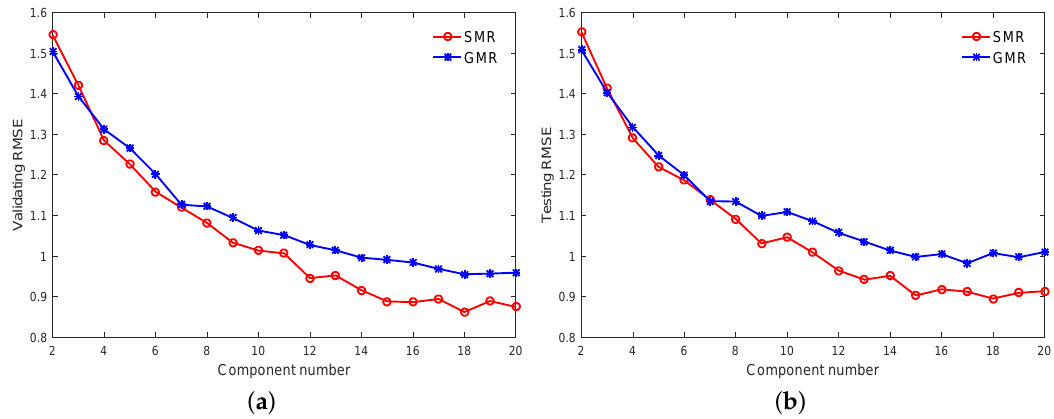
Figure 11. The RMSE on: ( a ) the validating datasets, ( b ) the testing